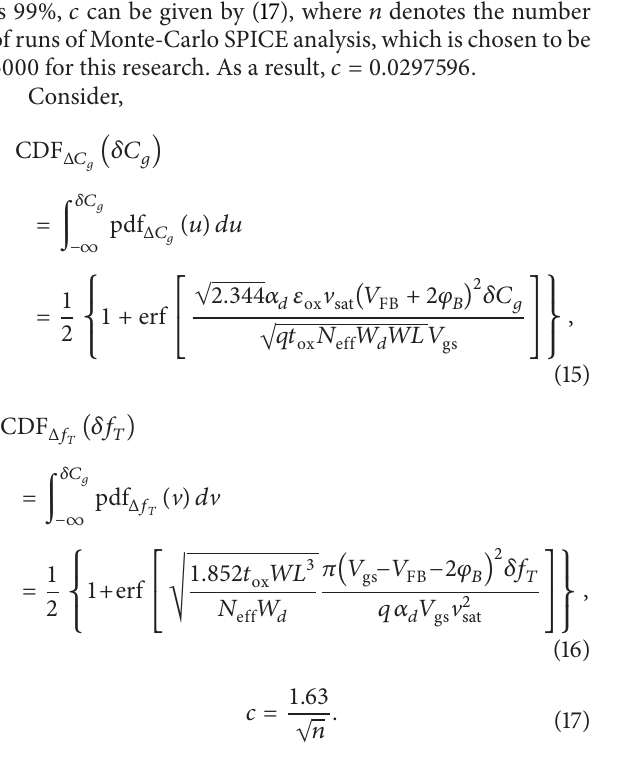
(𝛿𝐶 ) based on NMOS 𝑔 𝑔